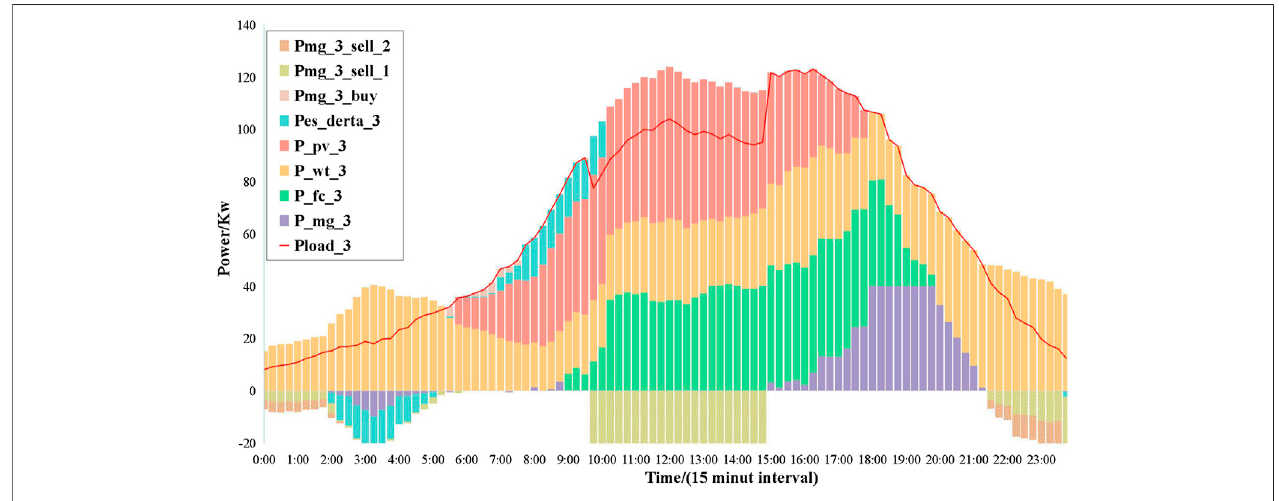
FIGURE 9 | Power balance of MG3.